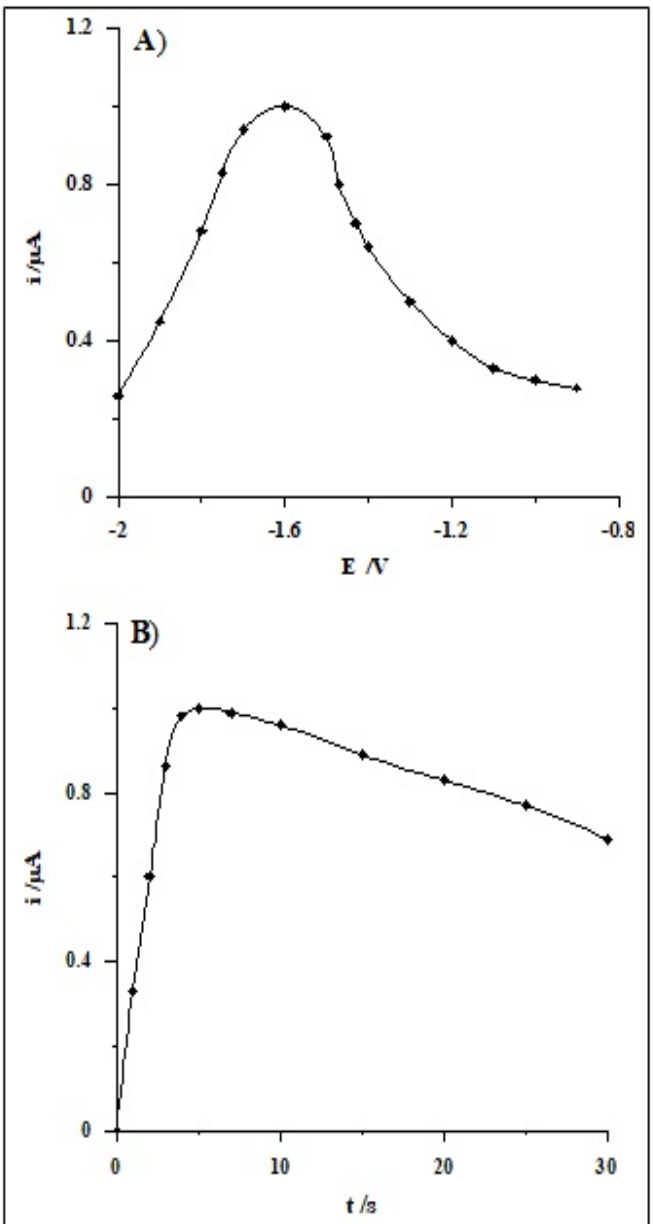
Figure 3. The impact of first accumulation potential ( A ) and its time ( B ) on the voltammetric signal of Se(IV). Steady concentration: 1 × 10 − 7 mol L − 1 Se(IV), 0.1 mol L − 1 acetic acid, 1.9 × 10 − 5 mol L − 1 Bi(III).